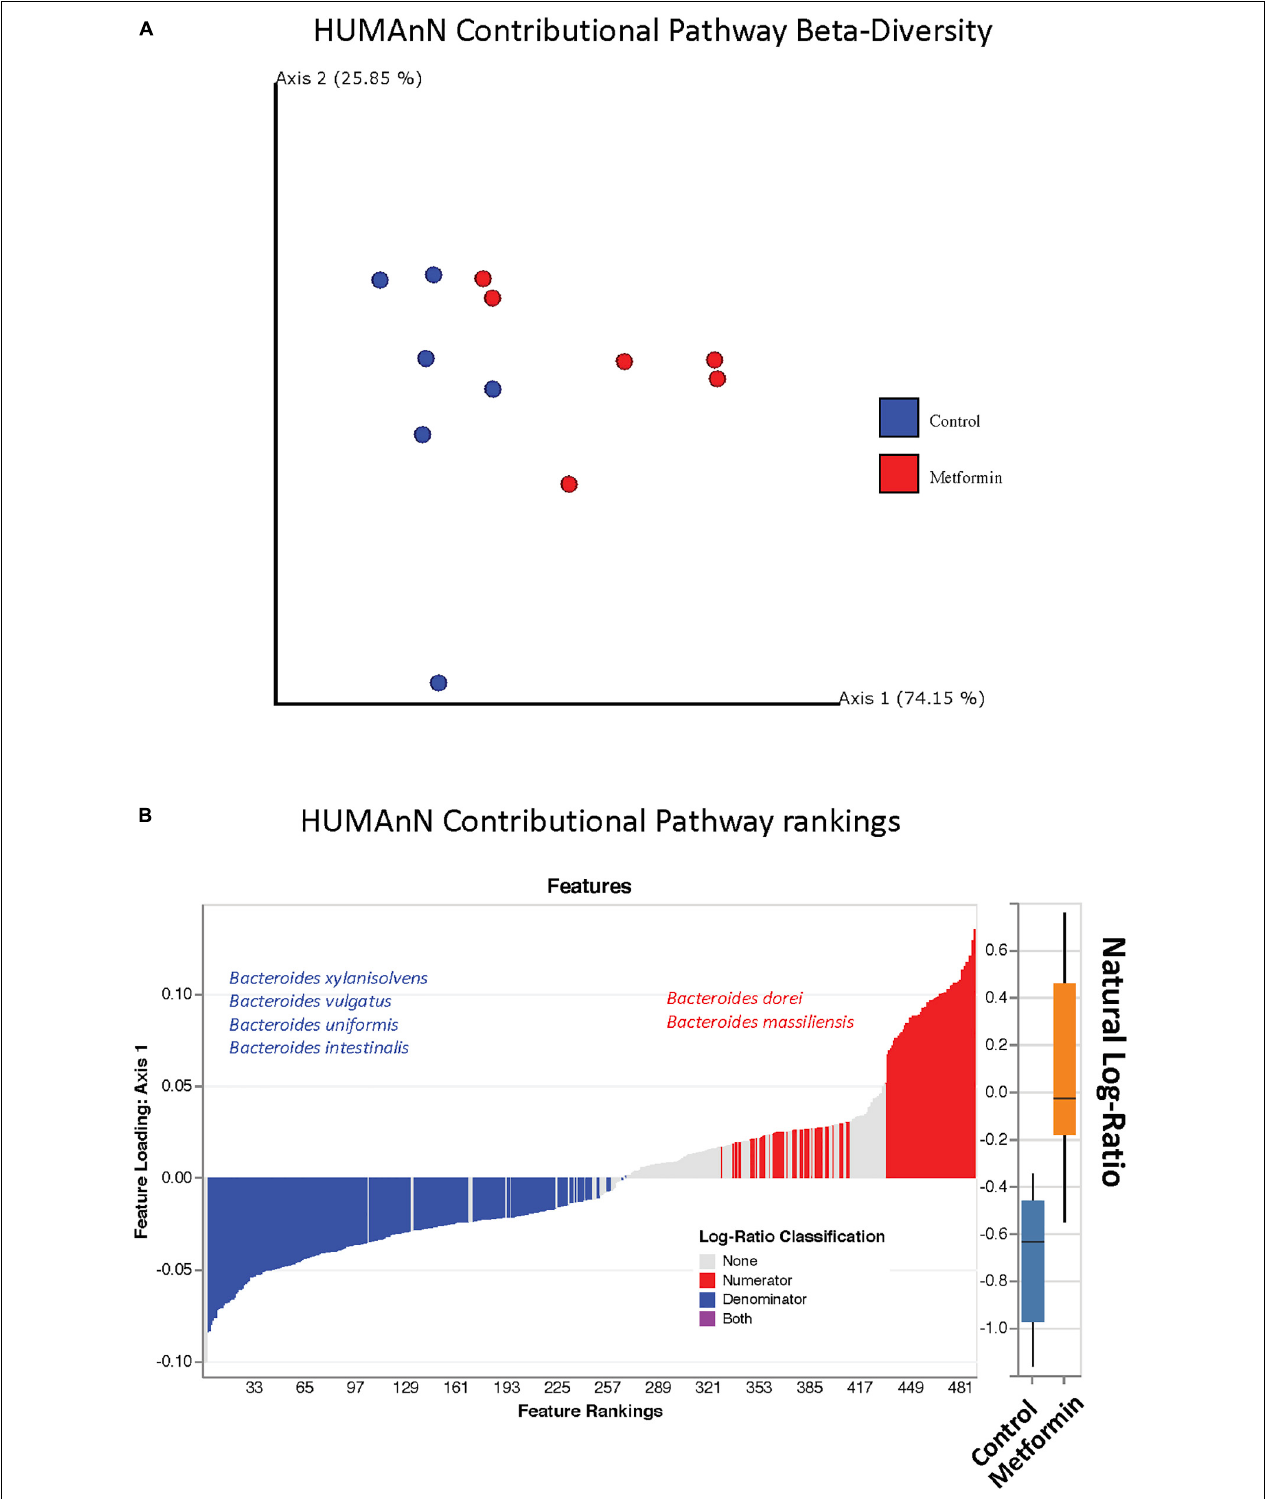
FIGURE 4 | (A) Robust Aitchison PCA plot of metagenome samples processed through HUMAnN and DEICODE and visualized with qurro. Pathways not present in at least 50% of samples were removed from the analysis. These values Separation of Control and Metformin treated groups was significant ( p -value 0.012). (B) Corresponding log-ratio rankings for Pathways oriented to Axis 1 (right), displaying only pathways contributed by Bacteroides spp. Numerator (red)/Denominator (blue) ratios of these pathways were computed to generate a box-whisker plot (left), p -value 0.008. These results were corroborated with songbird analyses.